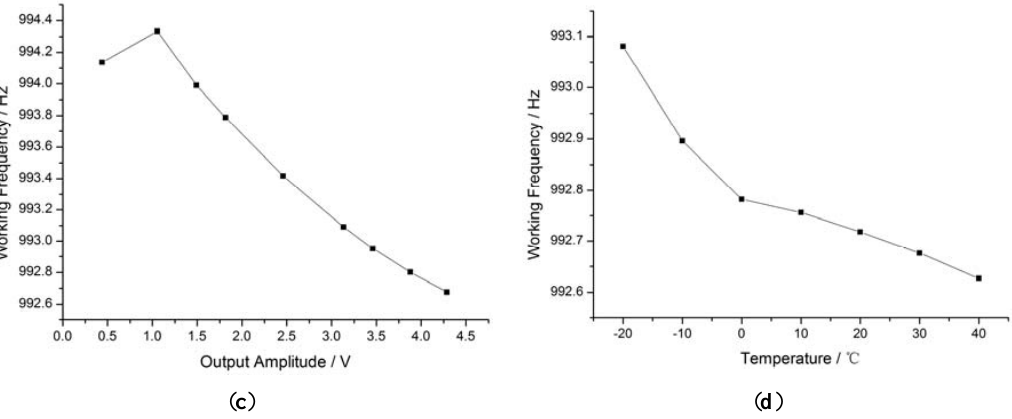
Figure 7. Features of the self-oscillating closed-loop system. ( a ) Sensitivity of closed-loop prototype; ( b ) response bandwidth; ( c ) vibration amplitude drift of the working frequency; ( d ) temperature drift of the working frequency.